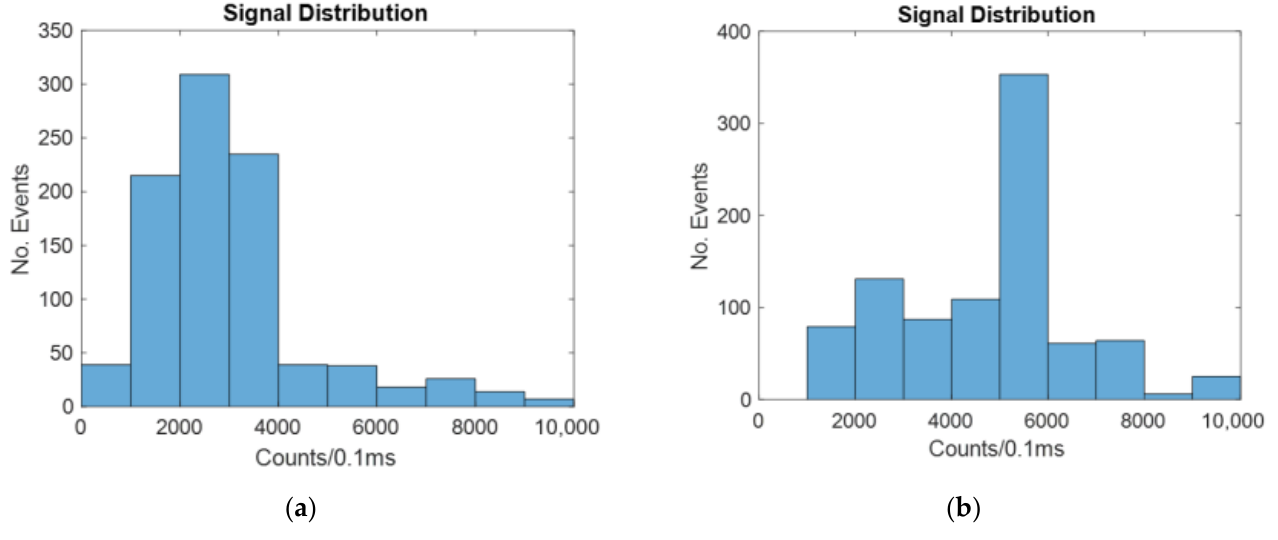
Figure 9. Histograms showing the number of counts at different intensities for a biosensor illuminated by a four-micron spot laser with: ( a ) no hydrodynamic focusing; ( b ) 2D hydrodynamic focusing. Similar to the windowed and line laser cases, 2D hydrodynamic focusing increases the signal by causing more of the particles to be in the center, which increases the likelihood of the signal reaching the detector. This is also shown in Table